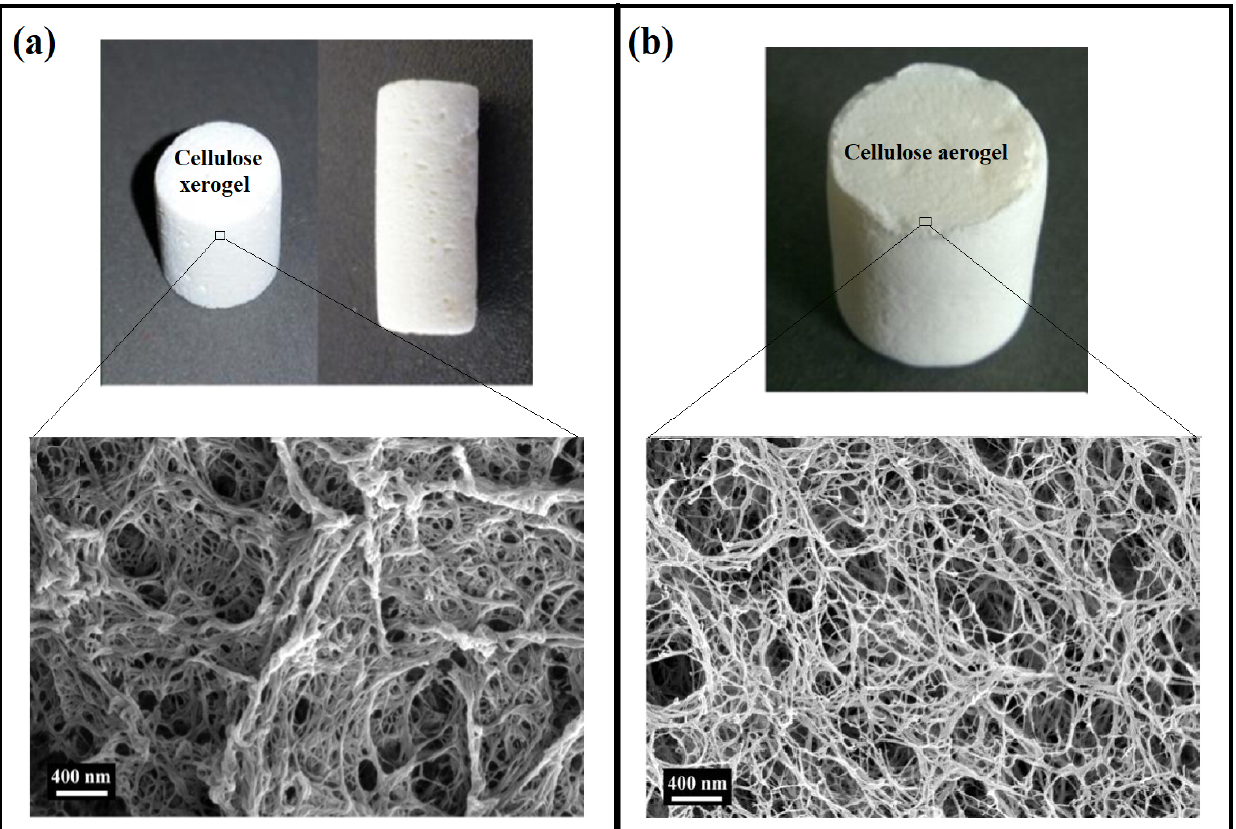
Figure 2. Comparison between cellulose xerogel and aerogel in term of shrinking and porosity; ( a ) present the xerogel sample of cellulose-based xerogel and the SEM image, and ( b ) present its aerogel and the SEM image. Adapted with permission from Ganesan et al. [39] Copyright 2016. Elsevier.